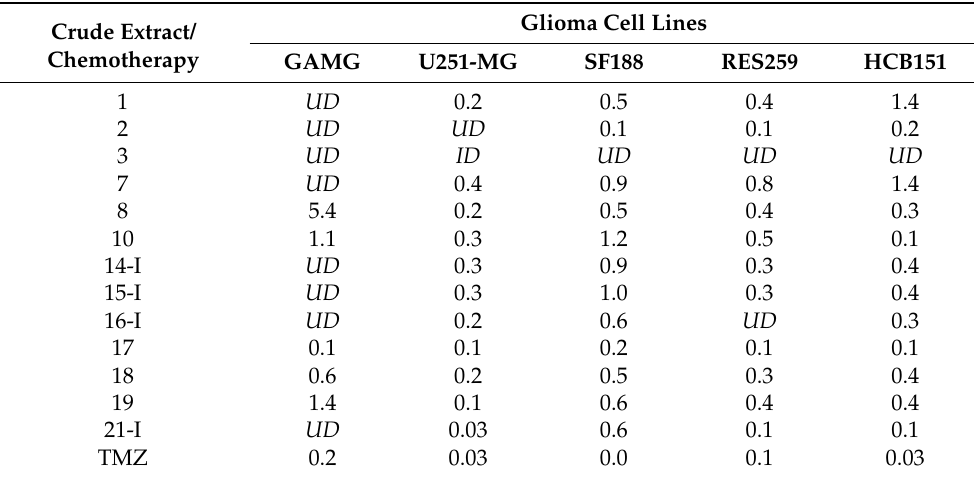
Table 2. Selectivity index for crude leaf extracts from plants of Brazilian cerrado biome and chemother- apy temozolomide.